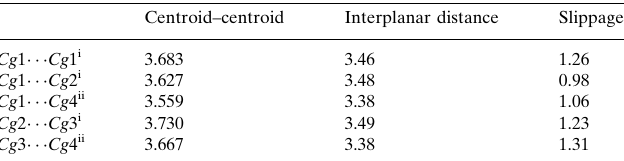
Table 1 (cid:2) – (cid:2) Interactions (A˚